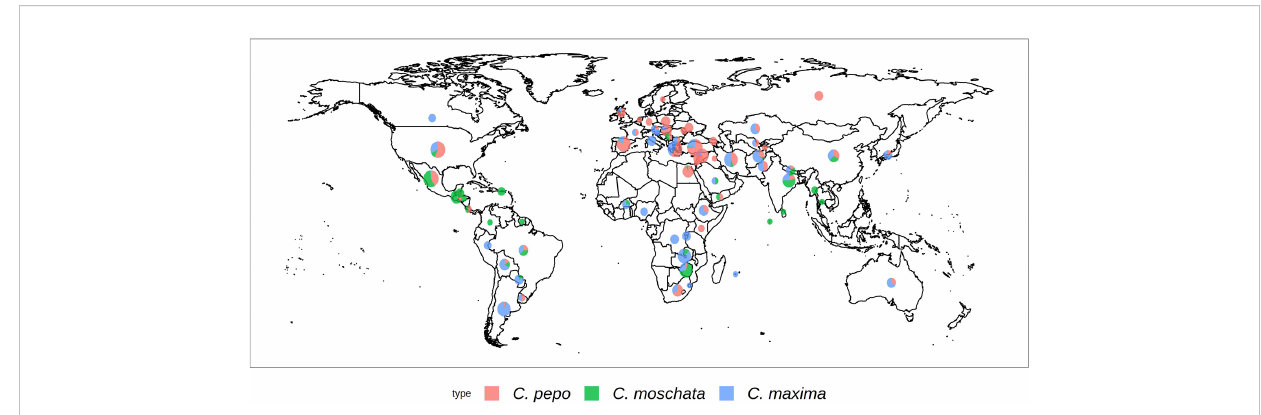
FIGURE 1 Geographical distribution of the USDA Cucurbita ssp. collection. The size of the pie chart is scaled according to the number of accessions. Sector areas correspond to the proportion of the